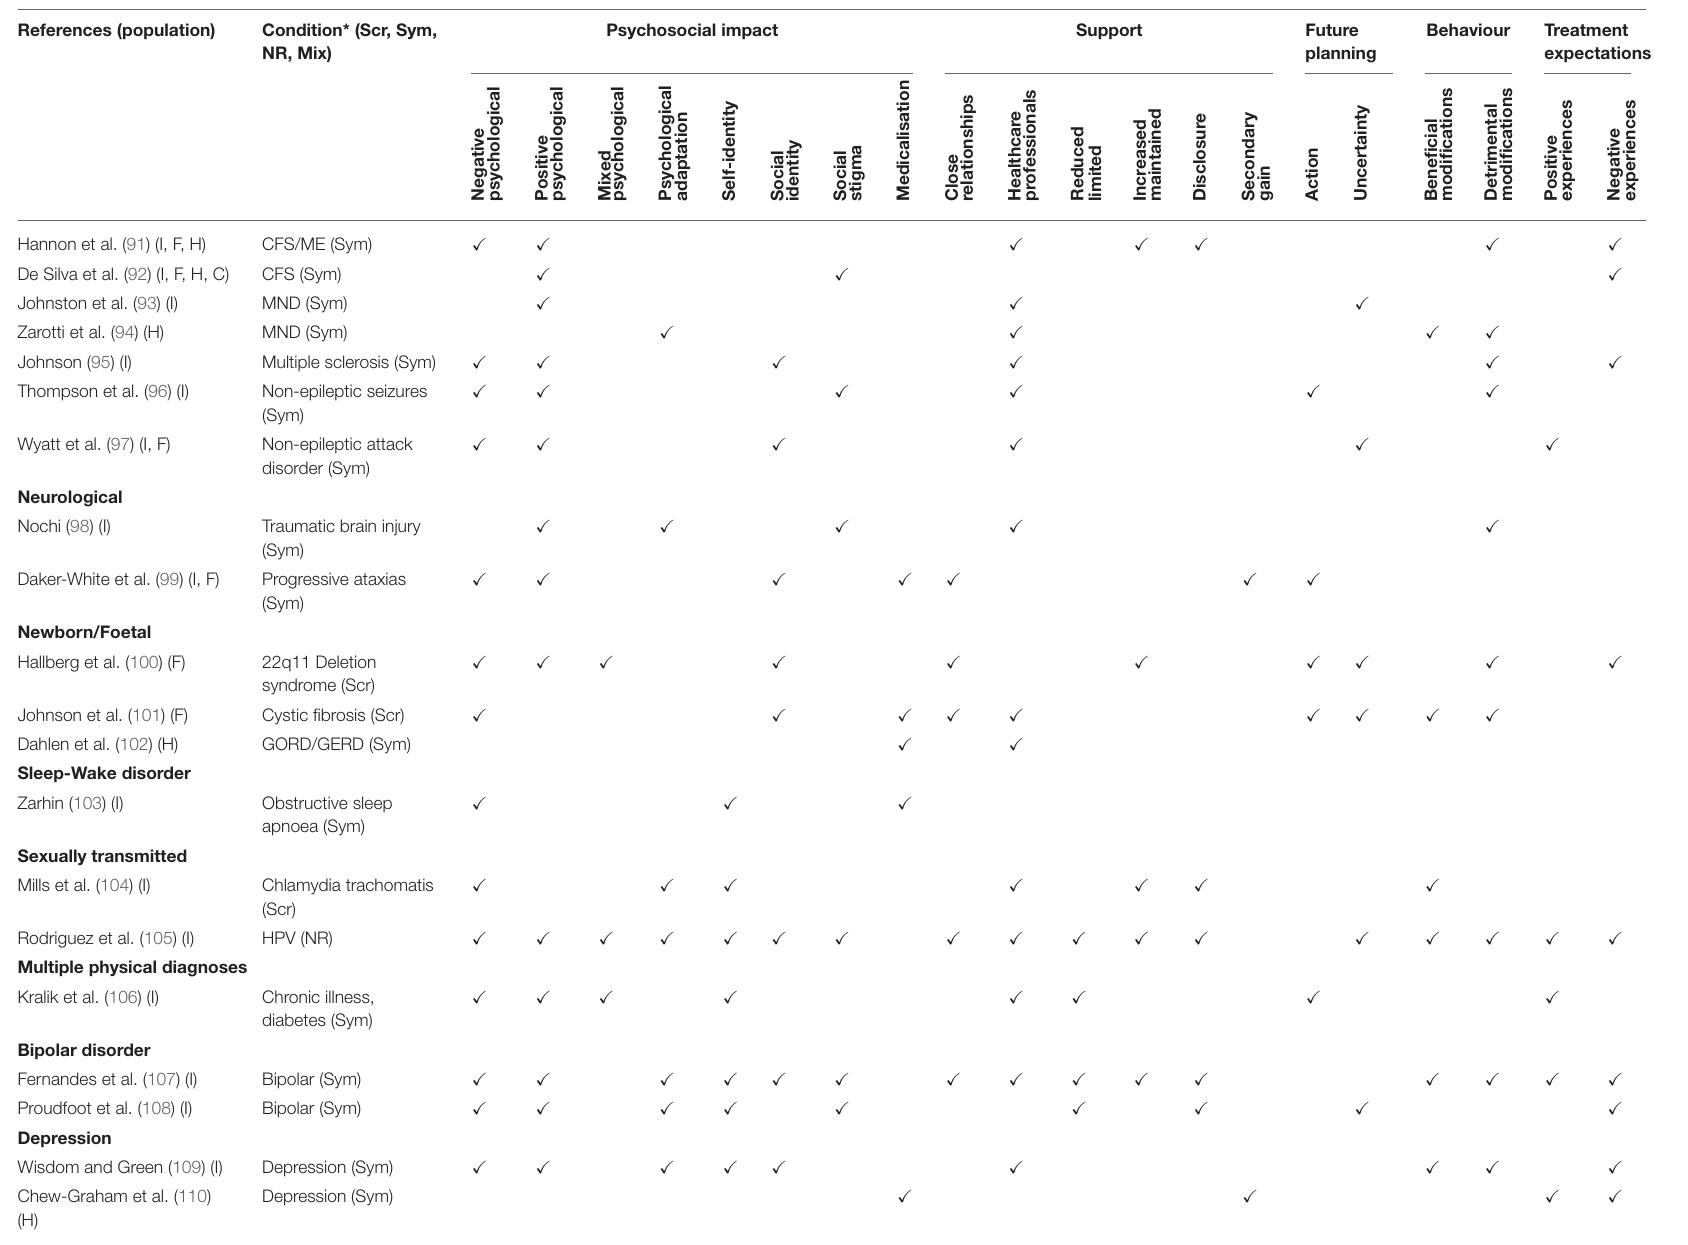
Multiple physical diagnoses X X X Kralik et al. (106) (I) Chronic illness, diabetes (Sym) Bipolar disorder Fernandes et al. (107) (I) Bipolar (Sym) Proudfoot et al. (108) (I) Bipolar (Sym) Depression Wisdom and Green (109) (I) Depression (Sym) Depression Chew-Graham et al. (110) (H)